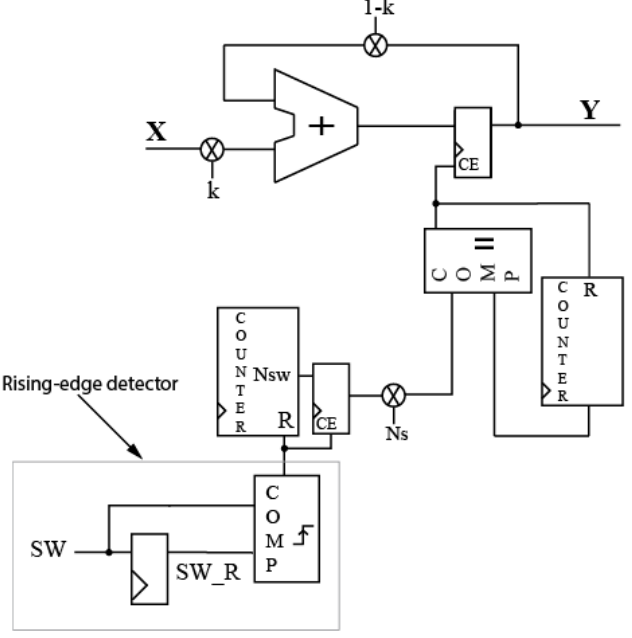
Figure 4. Digital schematic of the LOW-PASS filter.